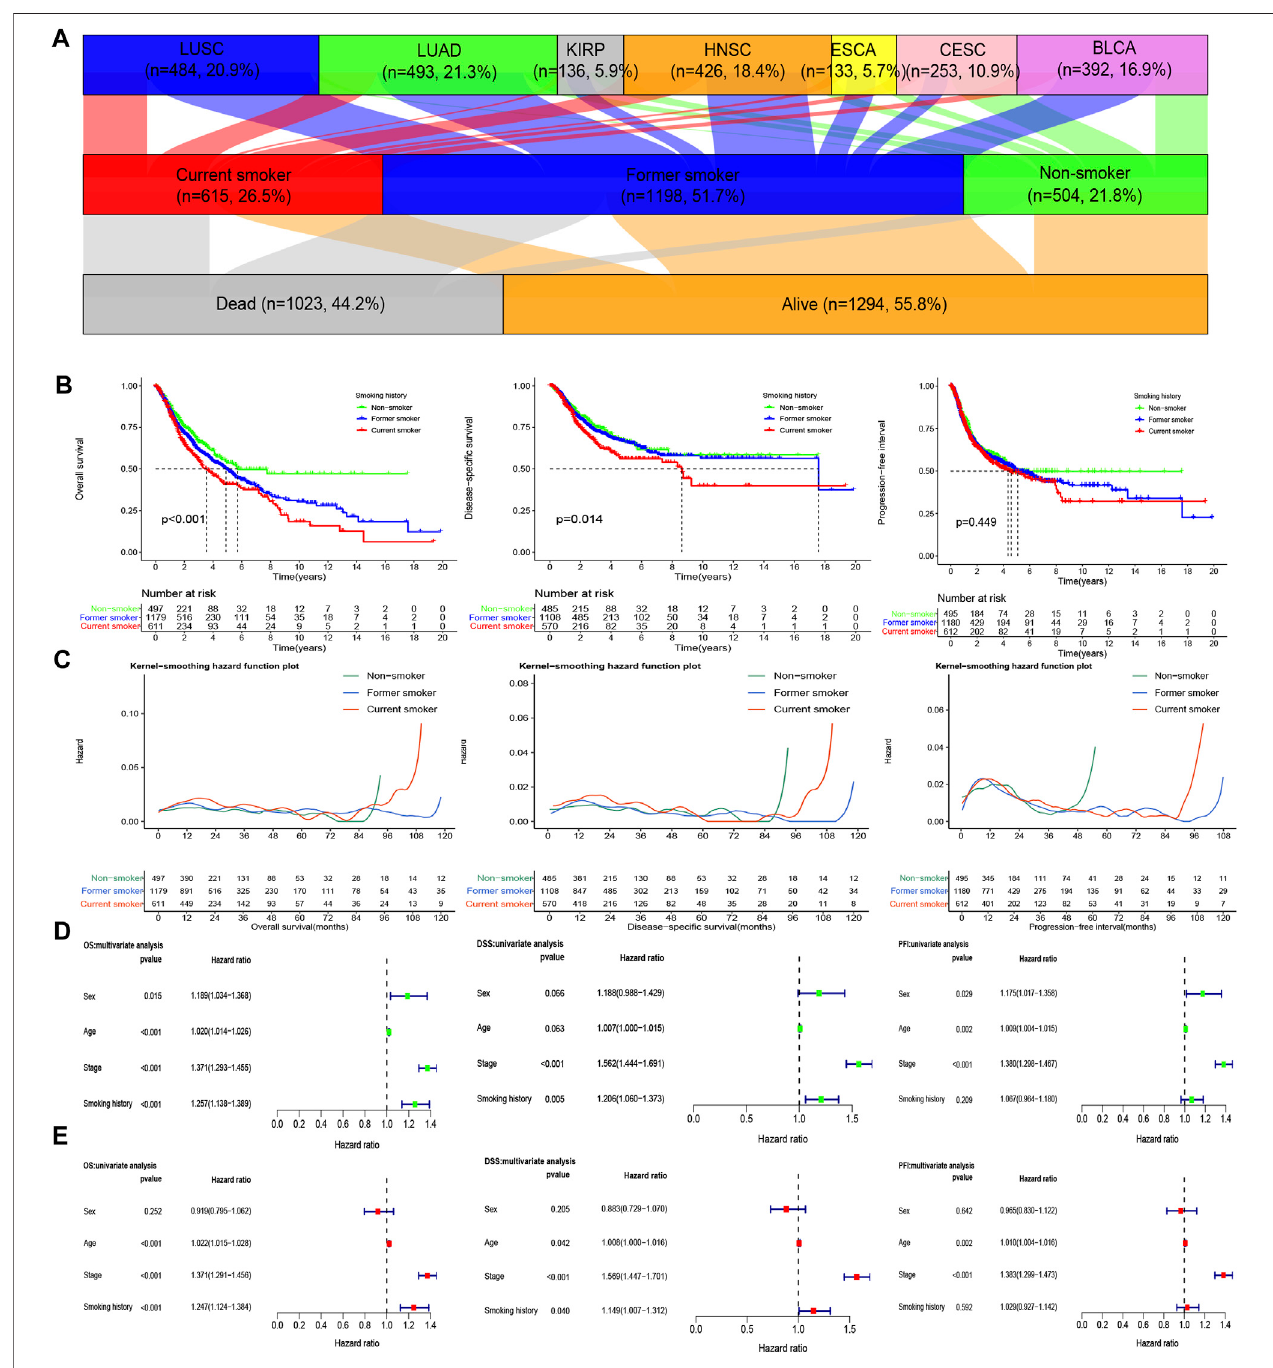
FIGURE2| In fl uenceofdifferentsmokinghistoriesontheprognosisindicatorsofcancerpatients. (A) TheSankeydiagramofcancertype,smokinghistory,andthe survival status of the included samples. (B) KM curves showed differences in OS, DSS, and PFI among patients with different smoking histories. (C) The smoothed hazard estimates of OS, DSS, and PFI in different smoking history patients. (D,E) The Cox regression analysis evaluated the in fl uence of different smoking histories on OS, DSS, and PFI along with other clinical features.